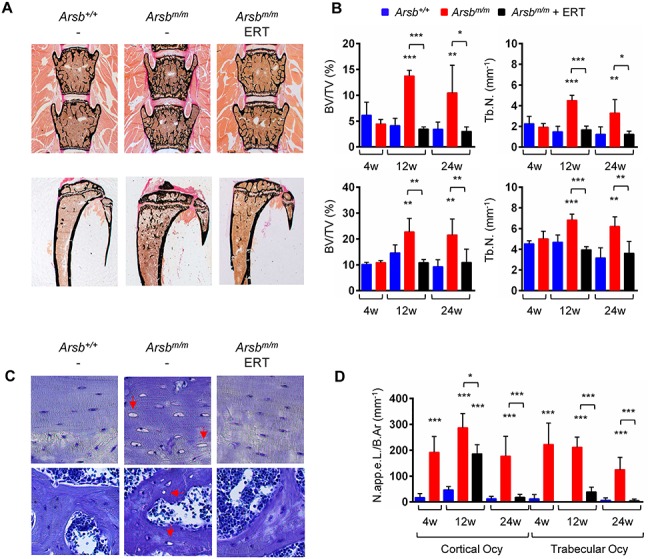
ERT prevents bone-remodeling pathologies in Arsb-deficient mice. (A) Representative undecalcified spine (top) and tibia (bottom) sections from 24-week-old wild-type (Arsb+/+), untreated (Arsbm/m) or treated (Arsbm/m ERT) Arsb-deficient mice after von Kossa-van Gieson staining. Mineralized bone matrix appears black. (B) Quantification of trabecular bone mass (BV/TV) and Tb.N. in spine (top) and tibia (bottom) sections from wild-type (blue bars), untreated (red bars) or treated (black bars) Arsb-deficient mice at 4, 12 or 24 weeks of age (n ≥ 5 mice per group). (C) Representative images showing cortical (top) and trabecular (bottom) sections from 24-week-old wild-type (Arsb+/+), untreated (Arsbm/m) or treated (Arsbm/m ERT) Arsb-deficient mice after toluidine blue staining. Enlarged and apparently empty osteocyte lacunae (indicated by the arrows) are specifically observed in untreated Arsbm/m mice. (D) Quantification of apparently empty osteocyte lacunae (N.app.e.L./B.Ar., number of apparently empty lacunae per bone area) in cortical and trabecular bone from wild-type (blue bars), untreated (red bars) or treated (black bars) Arsb-deficient mice at 4, 12 or 24 weeks of age (n ≥ 5 mice per group). Data are expressed as mean ± SD. *P < 0.05, **P < 0.005, **P < 0.0005 (one-way ANOVA).